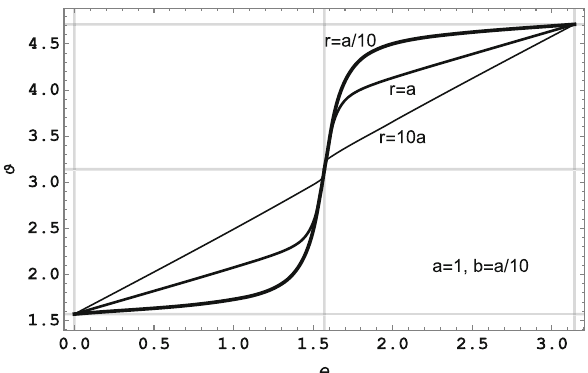
Fig. 1 Piecewise continuous representation of the tilt angle ϑ for an hypothetical thin disk approximately represented by the Kuzmin model described below field everywhere. Note also that in both cases the convective acceleration term has been